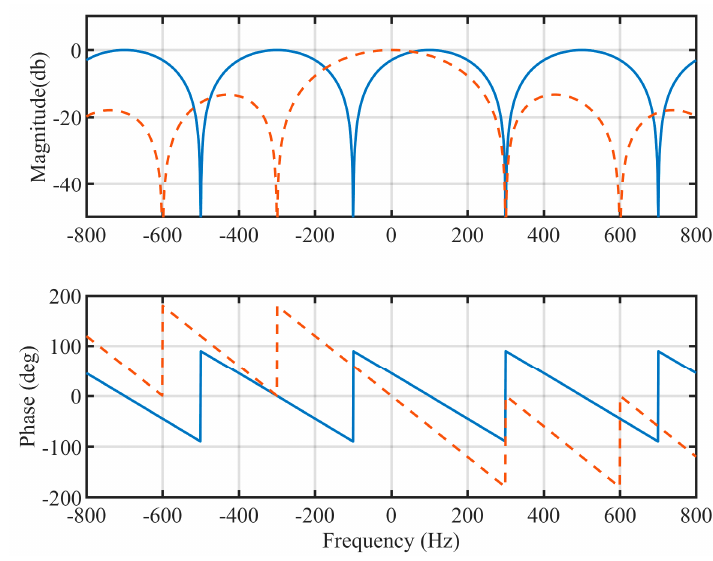
Figure 8. Bode diagram of MDSC m =4, n =8 and moving average filter (MAF).